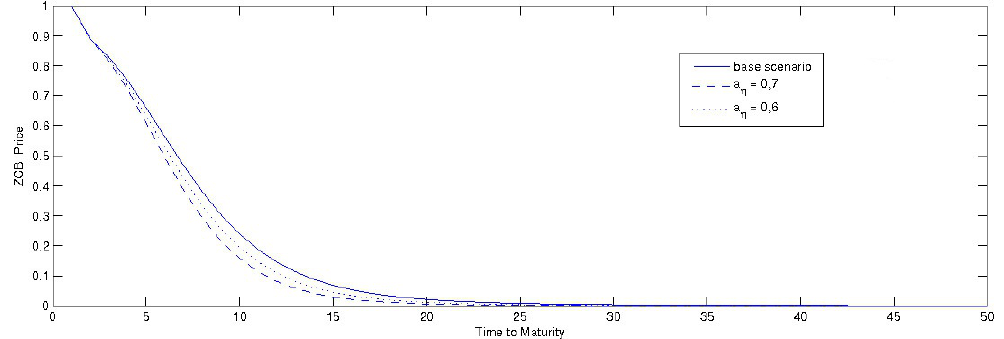
Figure 2. Zero coupon bond price based on different ambiguity